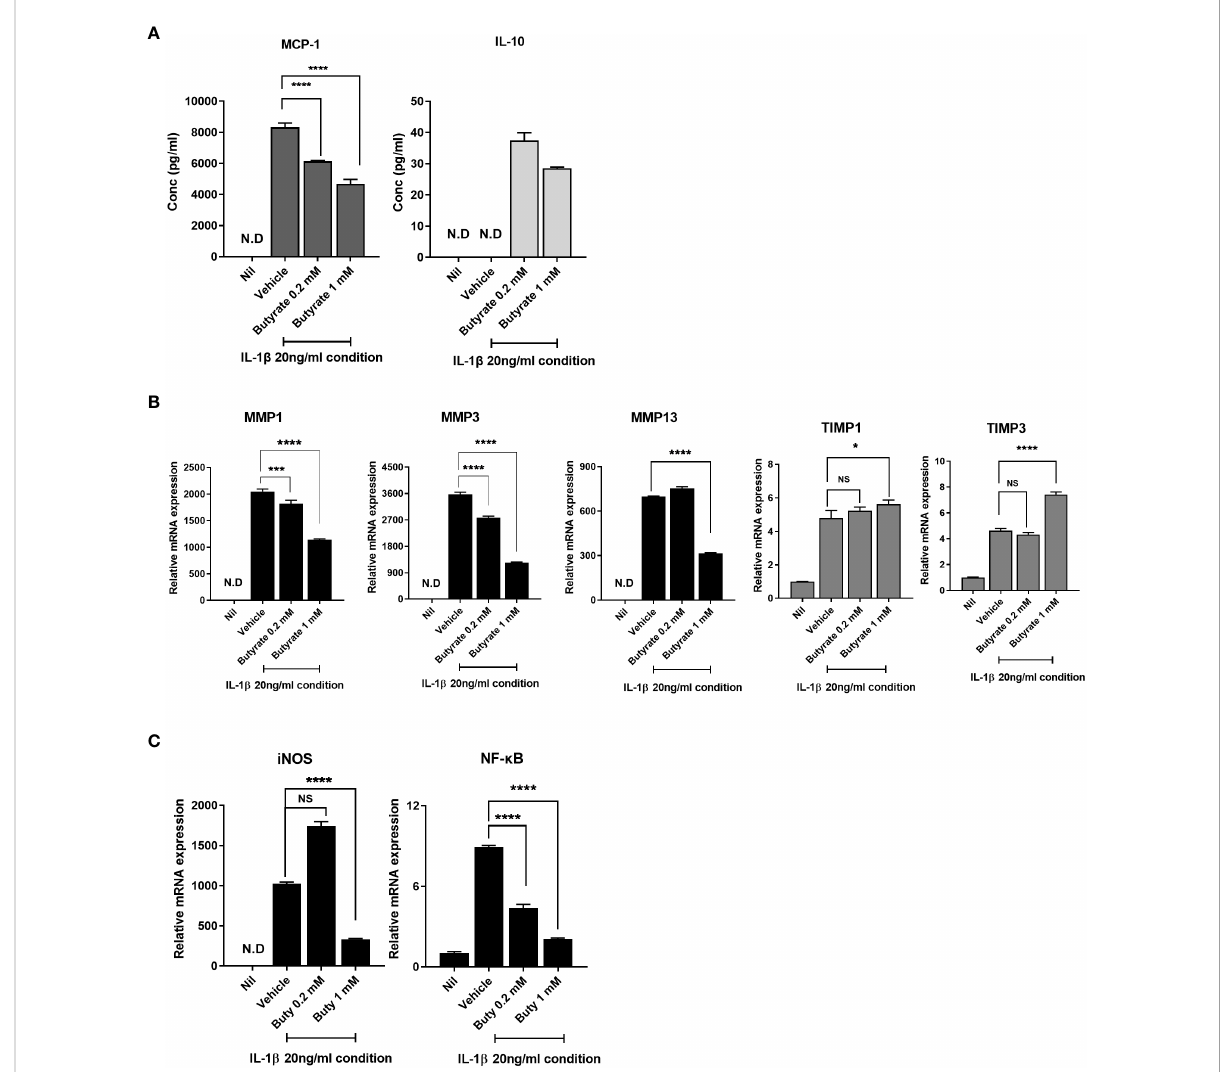
FIGURE 6 Butyrate rebalances anabolic/catabolism and suppresses the expression of in fl ammatory factors to prevent exacerbation of OA. (A) Protein levels of monocyte chemoattractant protein 1 (MCP-1) and interleukin 10 (IL-10) in chondrocytes cultured in serum-free medium with 20 ng/ml of IL-1 b for 24 h. (B) To determine the level of anabolic/catabolism expressed from chondrocytes upon butyrate treatment within an in fl ammatory environment, quantitative PCR was performed to determine mRNA levels. (C) Inducible nitric oxide synthase (iNOS) and nuclear factor kappa-light-chain-enhancer of activated B-cell (NF- k B) expression levels of chondrocytes under in fl ammatory conditions were analyzed by quantitative PCR. Data are means ± SD (* p < 0.05, *** p < 0.005, **** p < 0.001), nd, not detected; ns, not signi fi